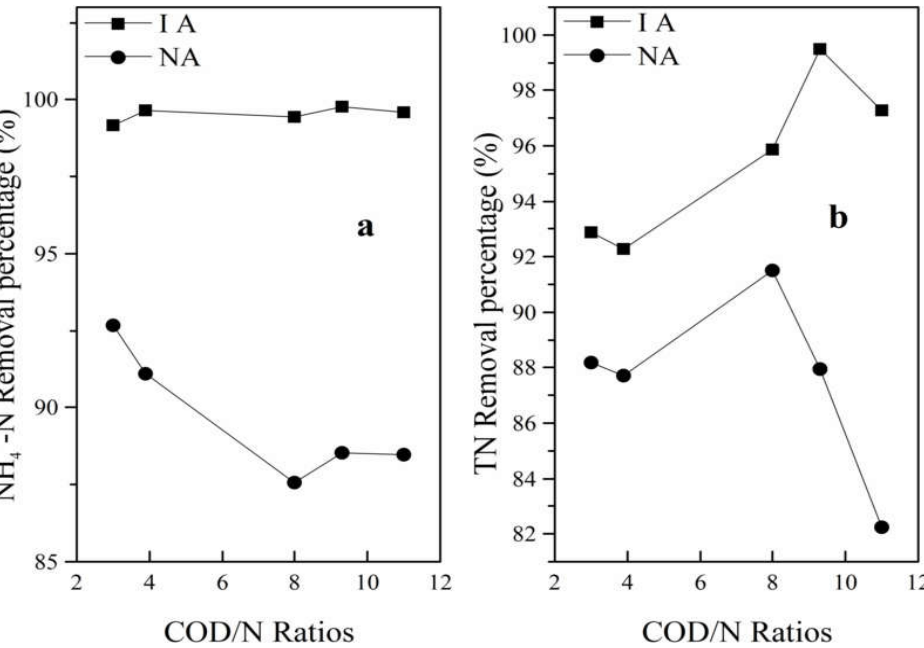
Figure 6. The removal efficiencies of NH 4+ -N ( a ) and TN ( b ) in HSSF-CWs with IA and NA under different COD/N ratios (IA: Intermittent aeration; NA: Non-aeration).